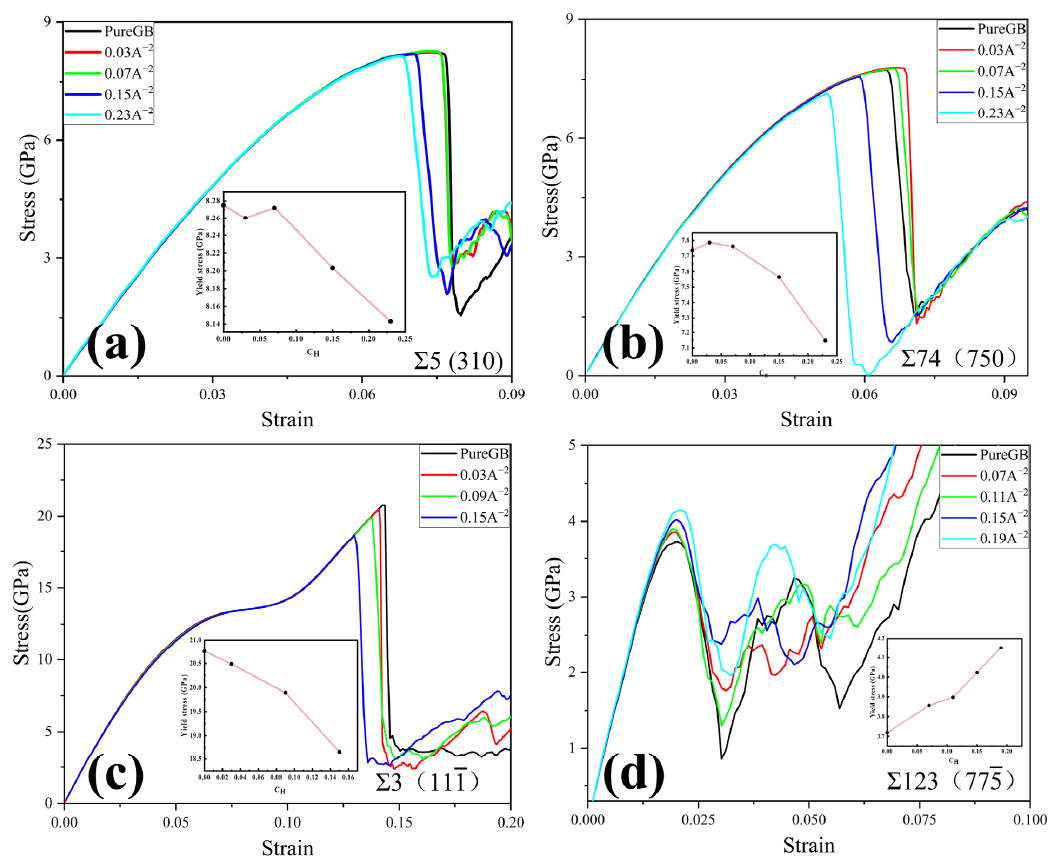
Figure 6. Stress-strain curves for ( a ) < 001 > and ( b ) < 11(cid:3364)0 > STGBs. The insets show the depend- ency of yield stress on misorientation angle.